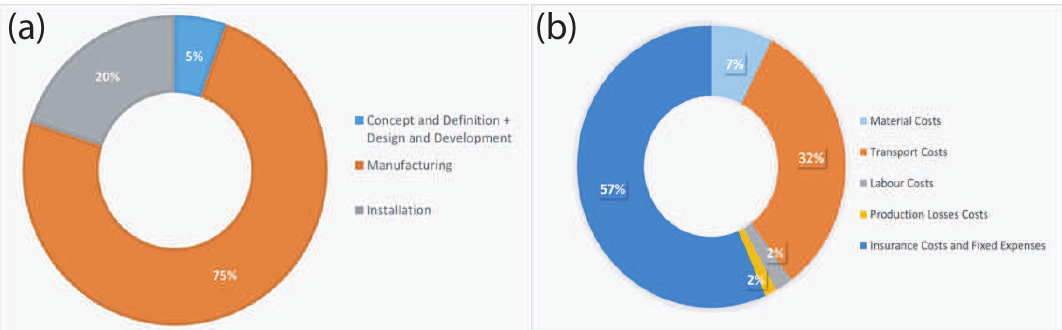
Figure 10. Cost distribution of the tidal farm: ( a ) CAPEX costs; ( b ) OPEX costs.